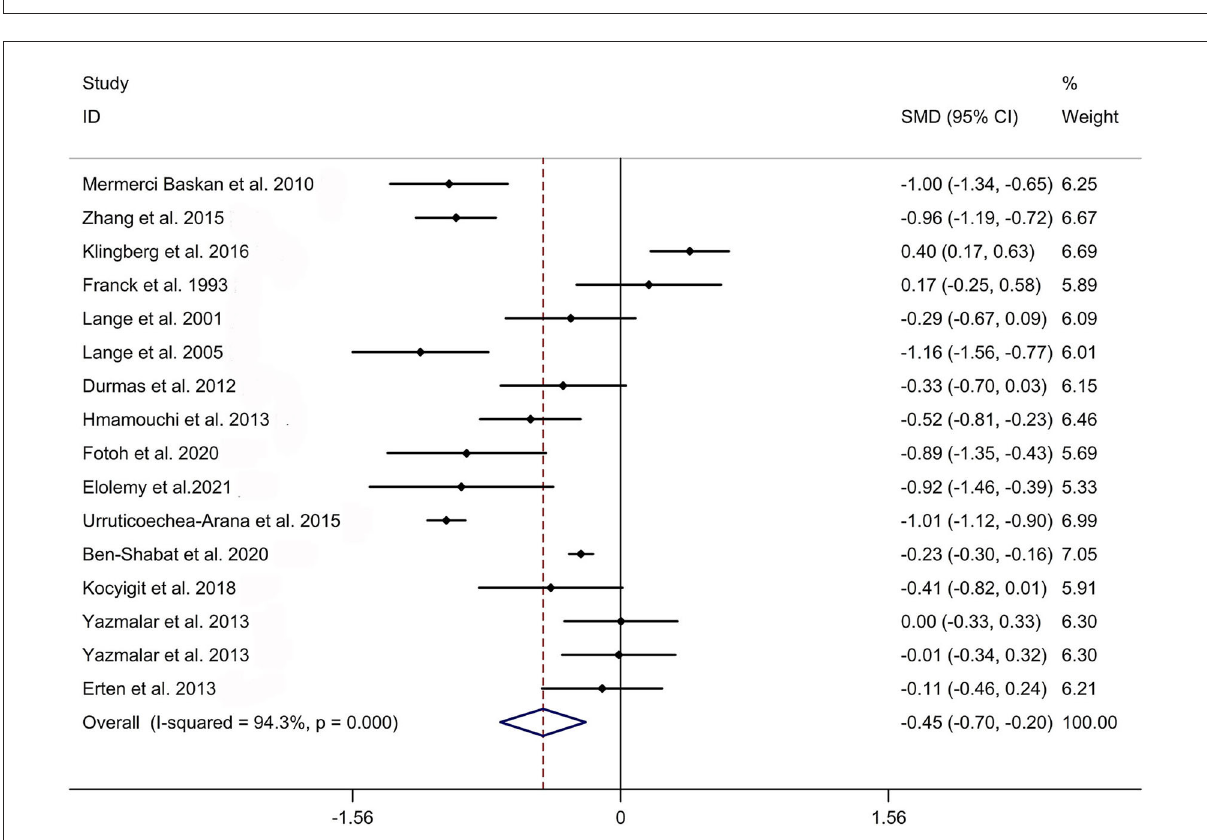
FIGURE1 Forest plot regarding comparison in peripheral 1,25OHD levels between AS and HC. AS, ankylosing spondylitis; HC, healthy controls; 1,25OHD, 1,25-dihydroxyvitamin D3.